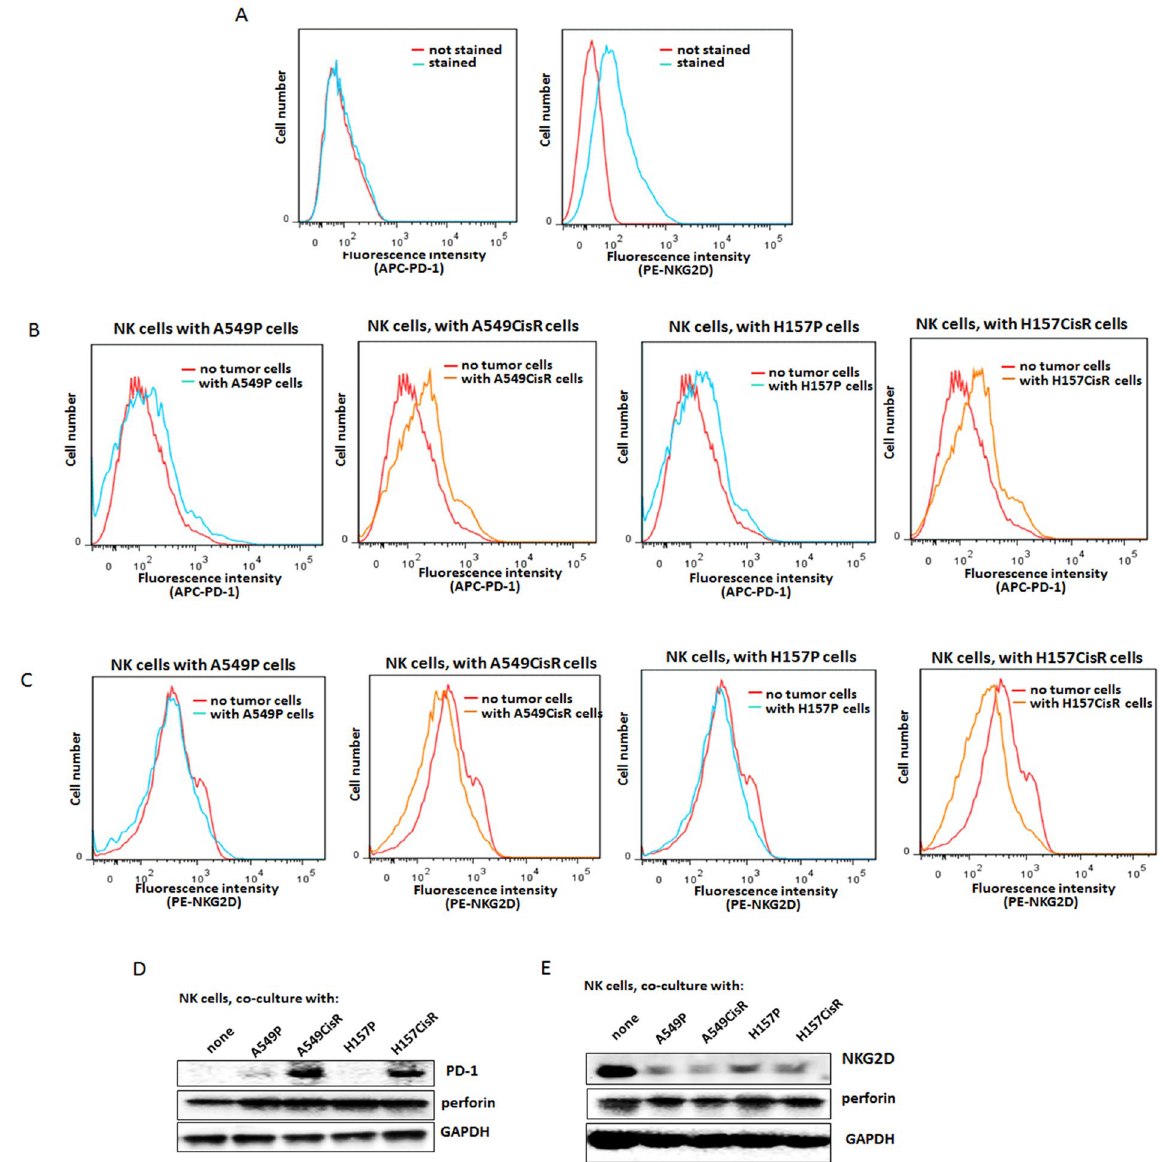
Figure 3. Expression of PD-1/NKG2D in NK cells, with or without co-culture with tumor cells. ( A ) Flow cytometric analyses of NKG2D and PD-1 in NK cells. Primary NK cells were stained with PE-NKG2D or APC-PD-1 and positive staining was analyzed. ( B ) Flow cytometric analyses of PD-1 on NK cells, after co- culture with tumor cells (6 hours of incubation). Primary NK cells were added into tumor cells (1:1 ratio, tumor cells:NK cells) and collected after 6 hours of incubation. PD-1 level in the collected NK cells were analyzed in flow cytometric analysis (using APC-PD-1 Ab). ( C ) Flow cytometric analyses of NKG2D on NK cells, after co- culture with tumor cells (6 hours of incubation). ( D ) Western blot analyses detecting PD-1 levels in NK cells after co-culture with tumor cells. NK92 cells were used in these tests. ( E ) Western blot analyses of NKG2D levels in NK92 cells when co-cultured with tumor cells. ** p < 0.01, *** p <